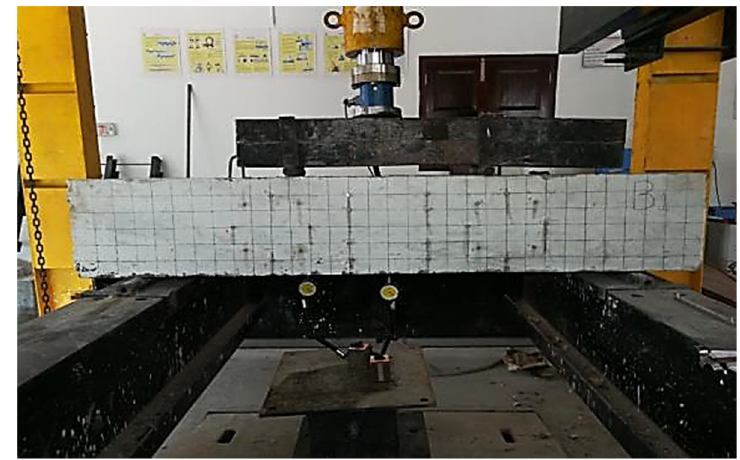
Figure 3. Test Set-Up for the Experimental Beams.